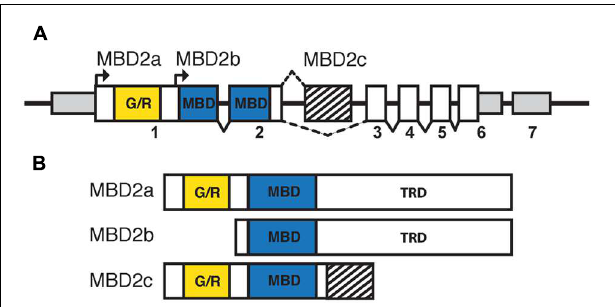
FIGURE 3 | The isoforms of MBD2 include different functional domains. (A) The Mbd2 transcript has seven exons, with non-coding regions (smaller gray box) in exons 1, 6, and 7. Coding regions are contained in exons 1–6 (white and filled boxes). The MBD (blue box) is split between exons 2 and 3 with the glycine/arginine rich region (yellow box) in exon 1. There are two translation start sites corresponding to MBD2a and MBD2b, respectively. MBD2c includes an alternatively spliced exon (striped box) between exons 2 and 3. (B) MBD2a utilizes the first translation start site and includes the G/R rich domain, MBD and C-terminal TRD. Translation of MBD2b excludes the N-terminal G/R rich domain. MBD2c includes the alternatively spliced exon and does not contain the C-terminal TRD.